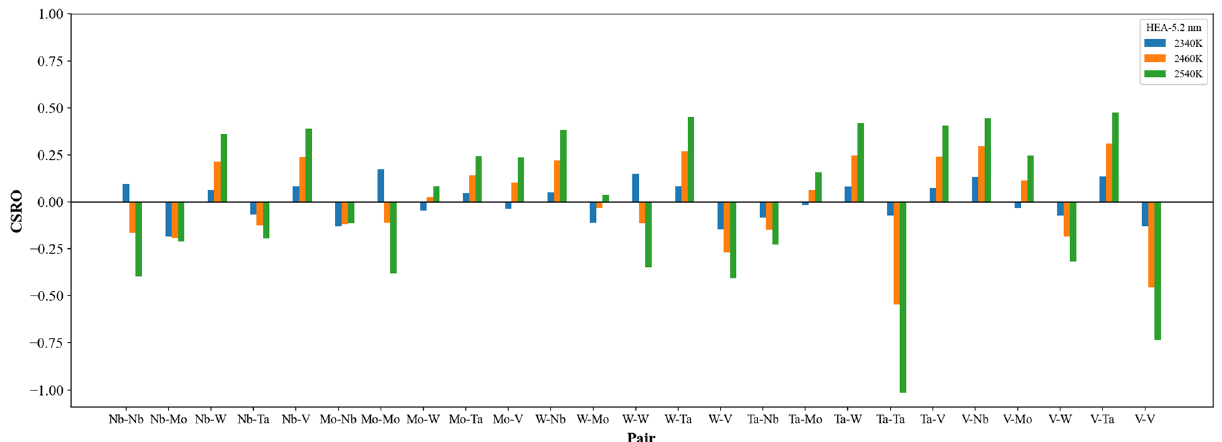
Figure 17. The CSRO distributions for the Nb 20.6 Mo 21.7 Ta 15.6 W 21.1 V 21.0 RHEA with the average grain size of 5.2 nm at 2340 (minimum of average CSRO square), 2460 (pre-melting temperature), and 2540 (melting point and the binding energy peak of grain atom)